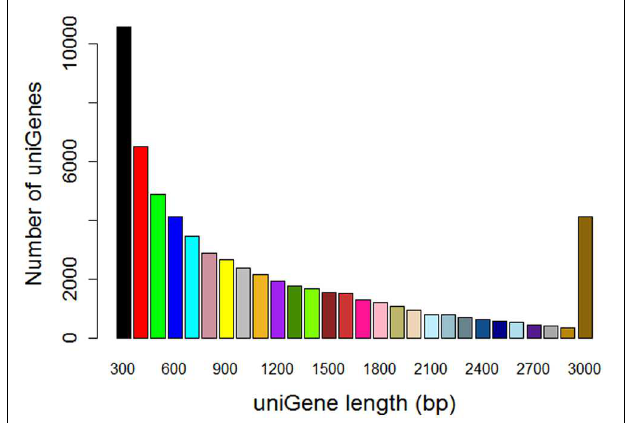
FIGURE 2 | Assembled unigenes length distribution of W. cocos transcriptome from mycelium and 2-months-old sclerotium.